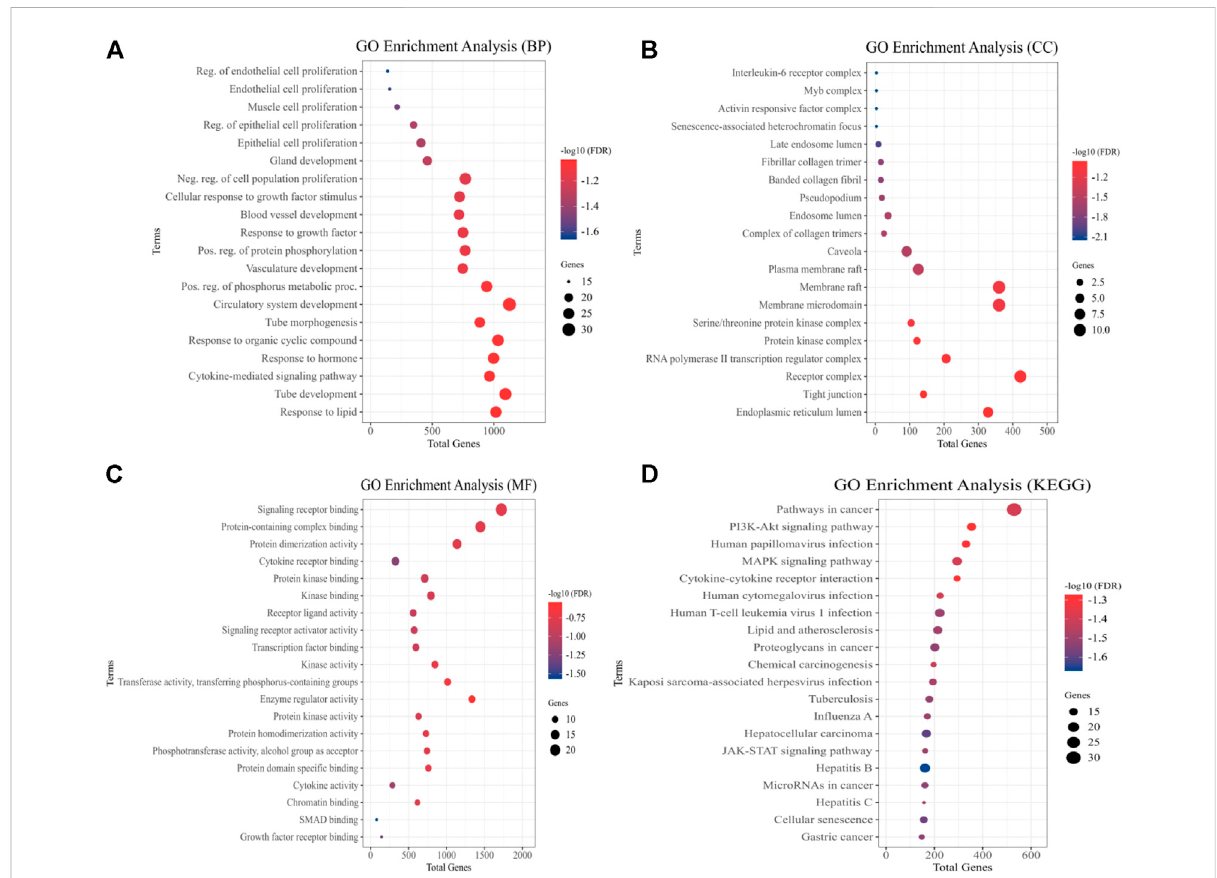
FIGURE 3 Quercetin targets were analyzed using GO and KEGG pathways. The y -axis depicts terms that are greatly enriched, while the enrichment score of these terms is shown on x -axis (A) Biological Processes (BP), (B) Cellular components (CC), (C) Molecular Function (MF), and (D) KEGG Pathways